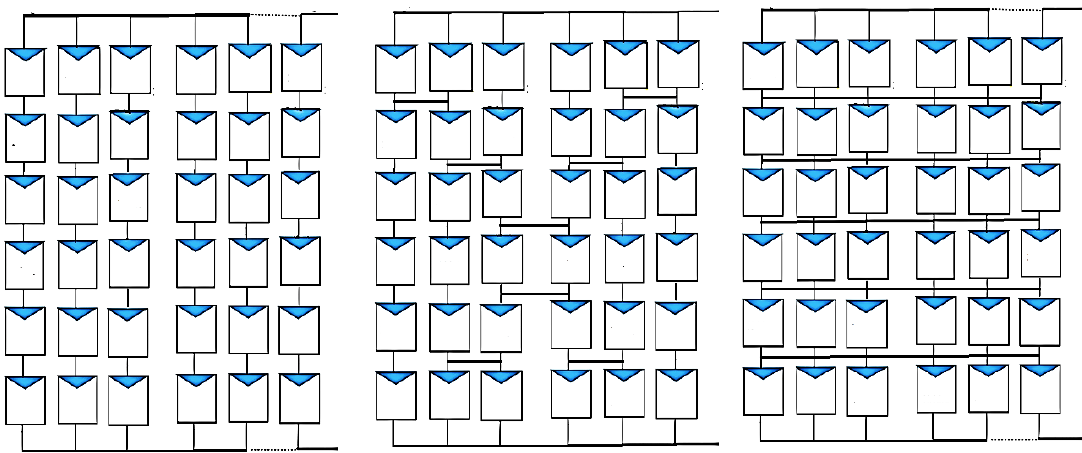
Figure. 4. SP interconnection ( Left ), HC interconnection ( Middle ), TCT interconnection ( Right ).